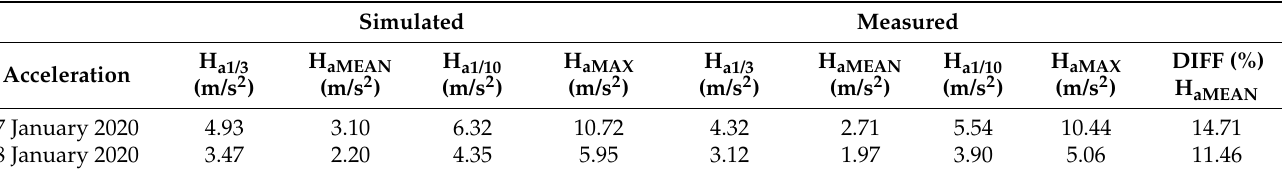
Table 6. Results comparison for vertical